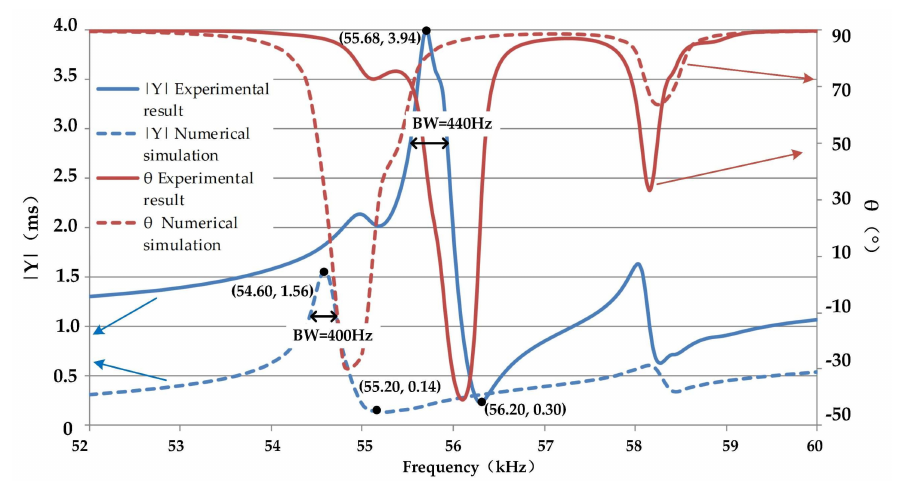
Figure 12. Impedance test equipment.